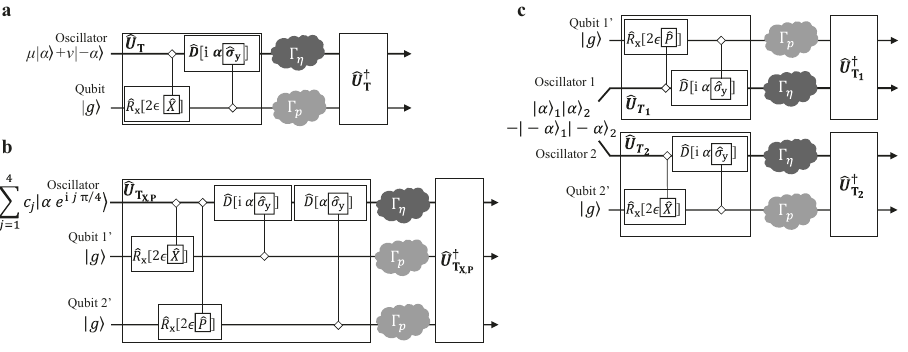
Fig. 1 Bypass protocol. a Schematic of the protection protocol for a superposition of two coherent states in a bosonic mode (thick), exploiting a single qubit bypass (thin). The oscillator and the ancillary qubit interact by a unitary coupling ^ U T made of two Rabi gates, i.e., controlled qubit rotation ^ U R ¼ exp ½ i ϵ ^ σ x ^ X (cid:2) ¼ ^ R x ½ 2 ϵ ^ X (cid:2) where qubit rotation is denoted as ^ R x ½ ϑ (cid:2) ¼ exp ½ i ϑ ^ σ x = 2 (cid:2) , and controlled displacement